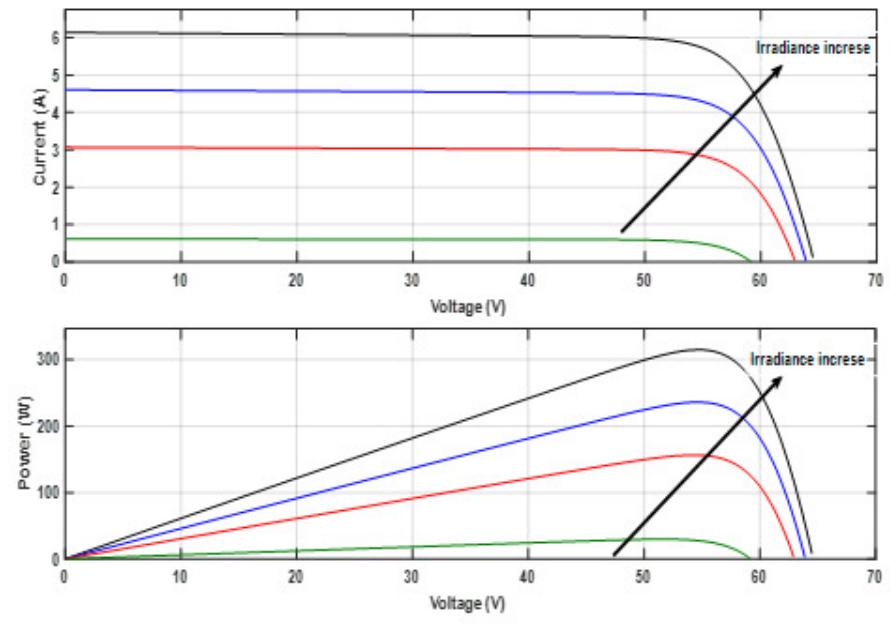
Figure 3. PV system characteristics at irradiation change a- I-V responses b- P-V responses